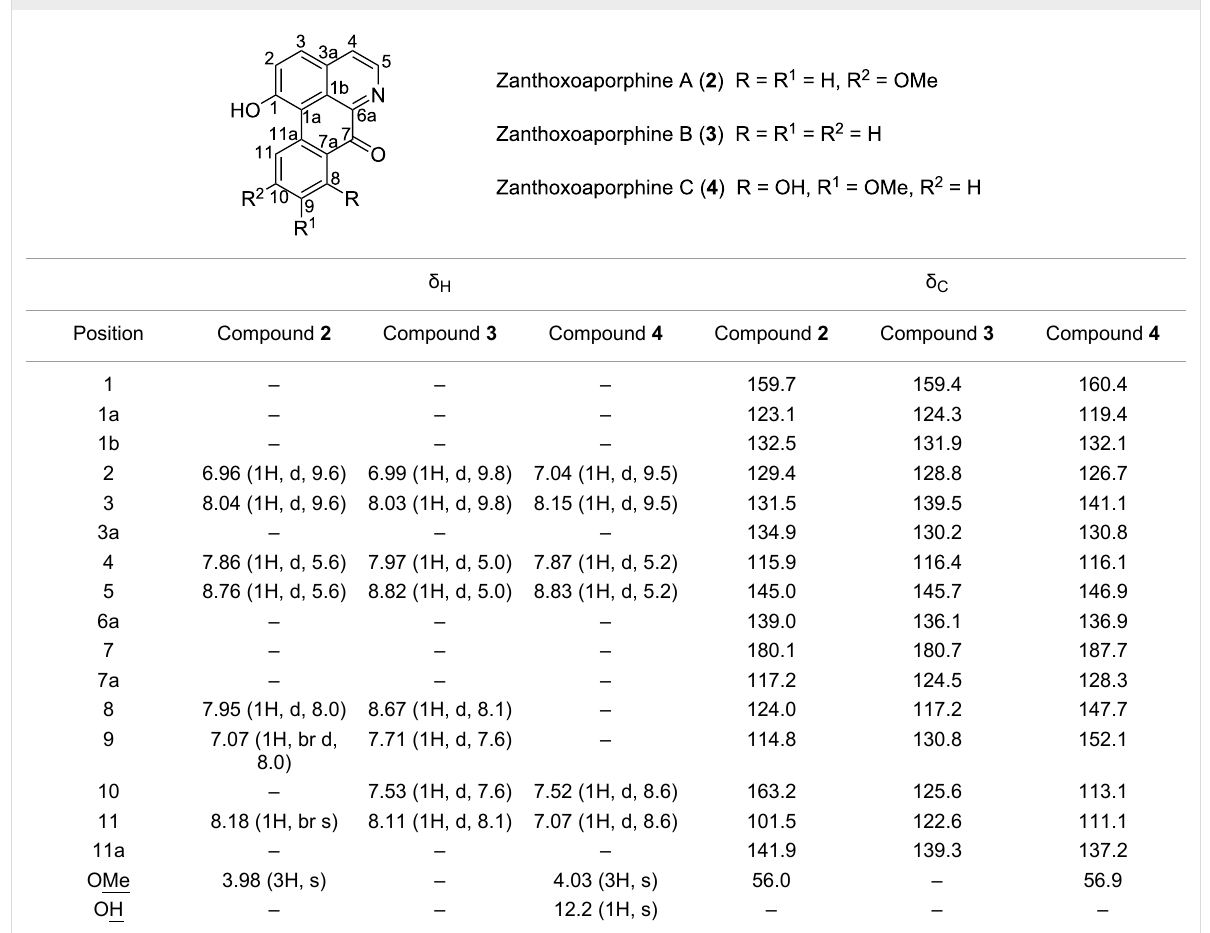
Table 2: NMR data of compounds 2 , 3 and 4 in CDCl 3